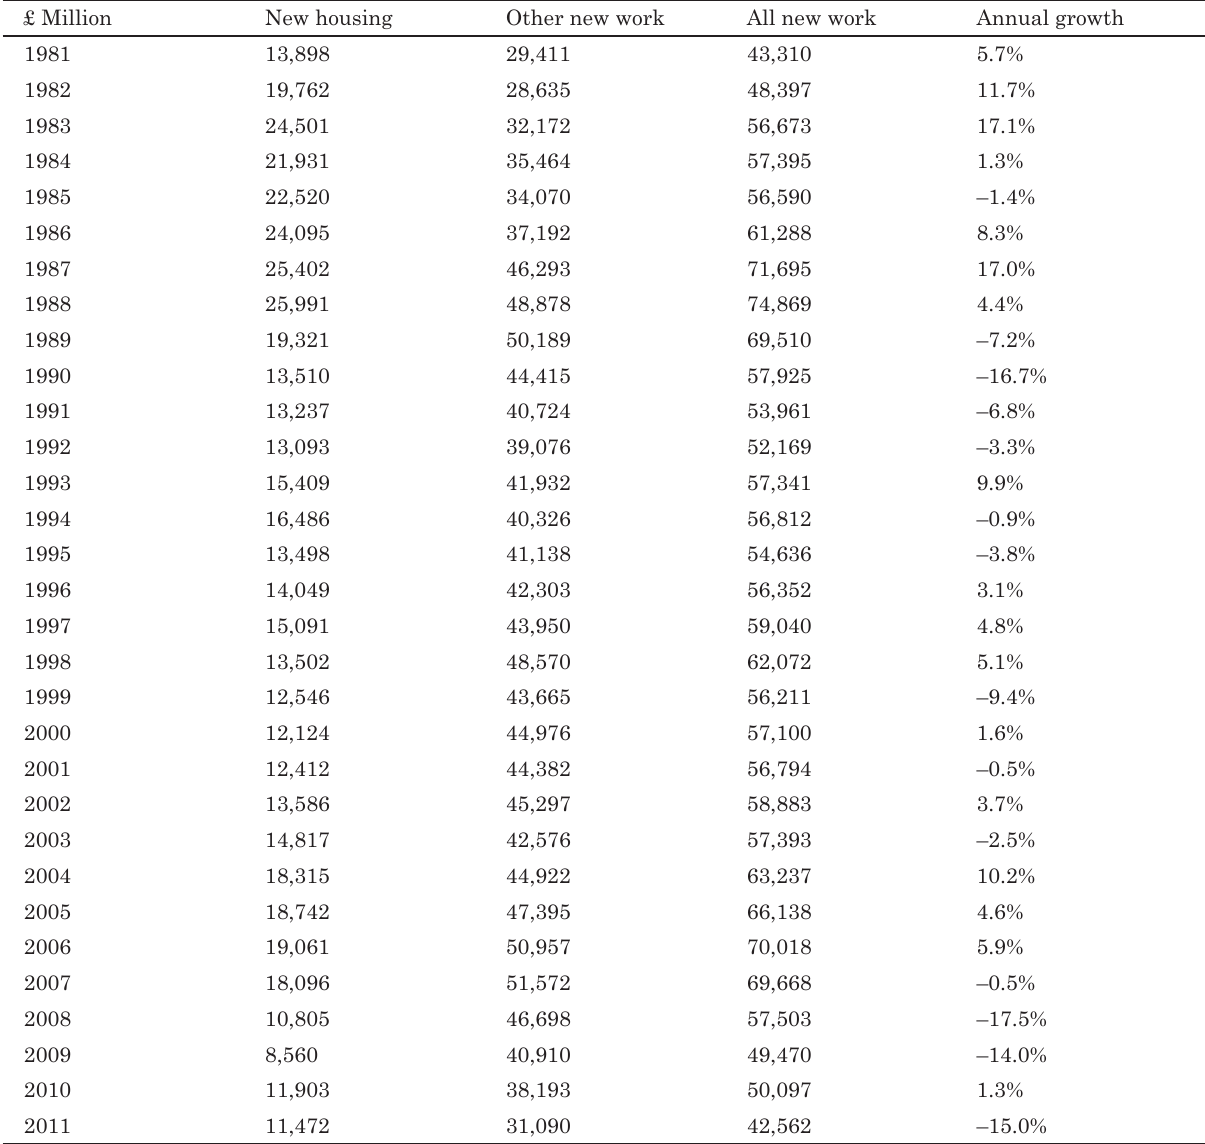
Table 1. Volume of orders for new construction by main contractors (1981–2011) at 2005 constant prices (Office